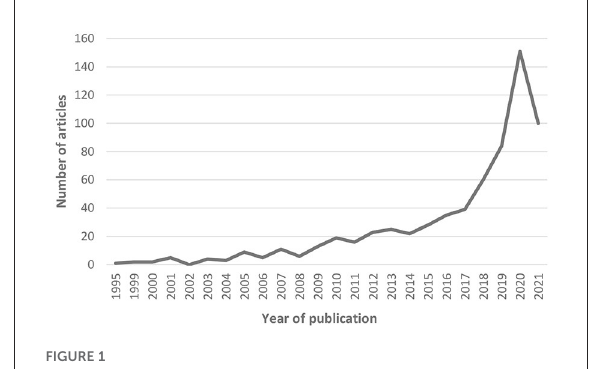
FIGURE1 Publications on farm animal welfare in 19 countries of Latin America between 1992 and 2021 according to CAB and WoS data bases ( n =